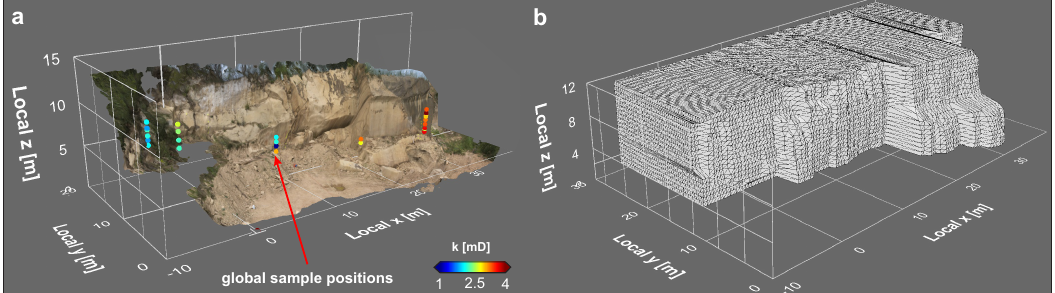
Figure 4. ( a ) Photogrammetric model of the investigated sandstone quarry in Obersulzbach, Germany. Sample locations are displayed as spheres, whose color indicates the observed permeability value at the sample locations. ( b ) Hexahedral non-orthogonal mesh of the investigated outcrop generated by an IDW interpolation using the nodes of the photogrammetric model as constraints. The quarry contains sequences from a prodelta mouthbar deposited as turbiditic